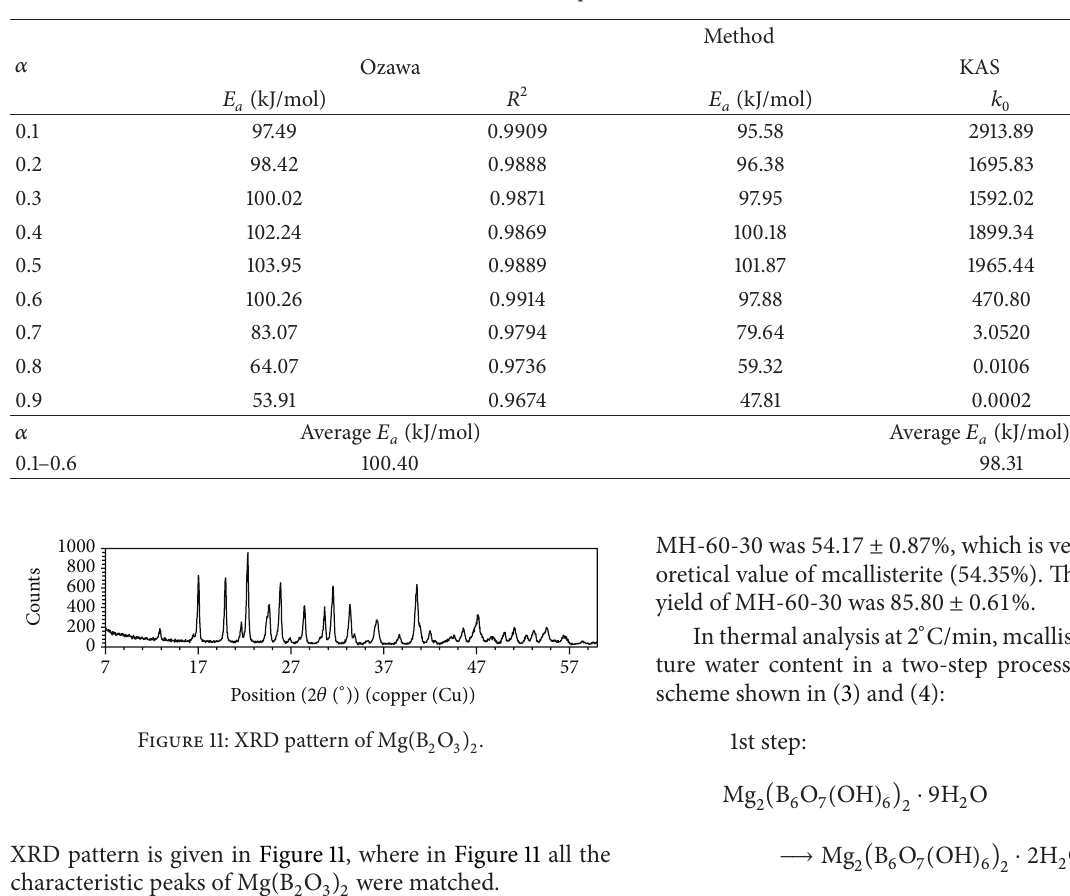
Table 4: Calculated kinetic parameters for KAS and Ozawa method.